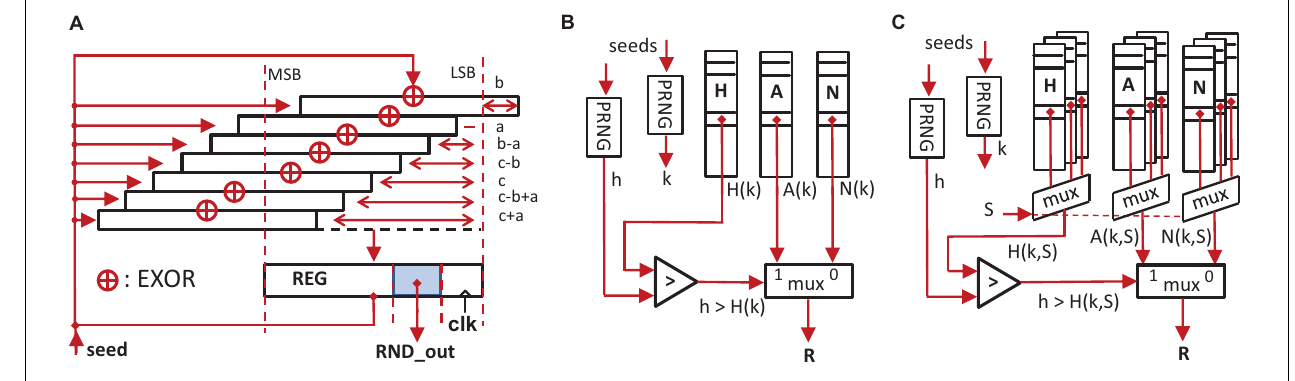
FIGURE 4 | (A) Xorshift-based implementation of a simple PRNG (Marsaglia, 2003b). (B) TBRNG. The index k represents a table address. (C) Multidimensional table-based random number generator (MTBRNG). The signal S selects a particular set of a ( H,A,N )